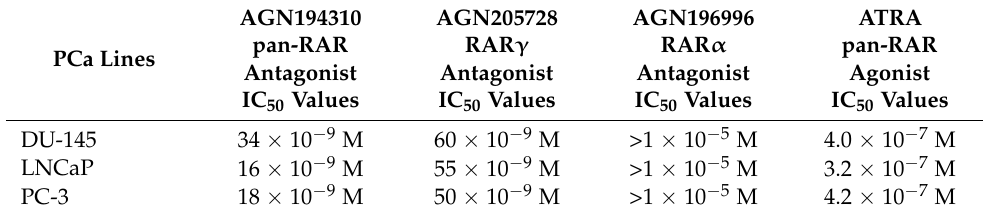
Table 3. Pan-RAR and RAR γ antagonists are potent inhibitors of colony formation by PCa cell